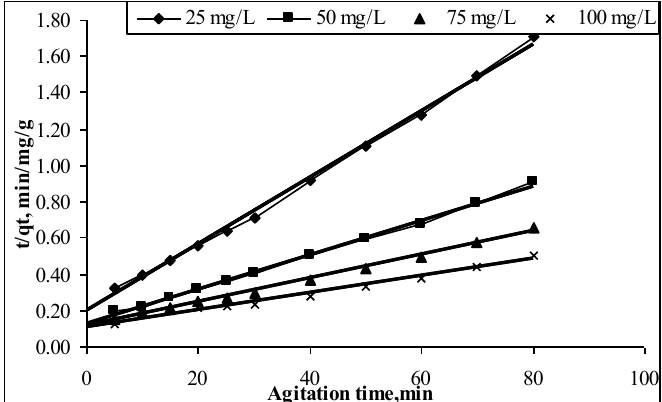
Figure 5. Pseudo-Second Order plot for Adsorption of RR onto